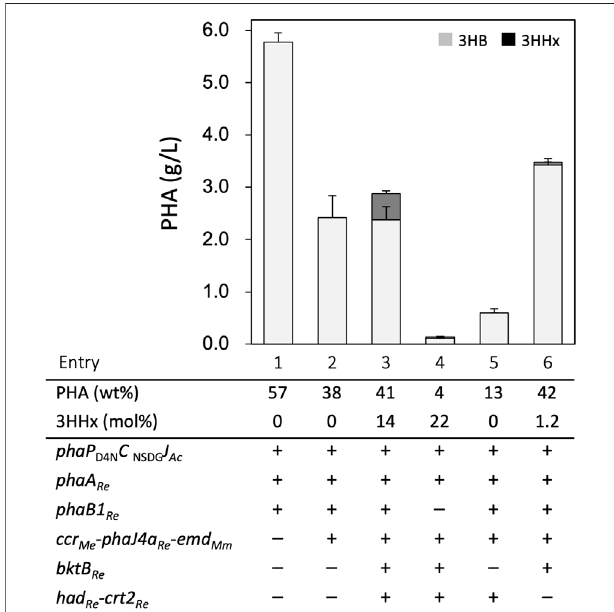
FIGURE2| P(3HB- co -3HHx)biosynthesisfromglucoseby E.coli JM109- derived recombinant strains. The amounts of 3HB and 3HHx units in PHA are showningrayand blackbars,respectively.Thecellswerecultivatedina100 ml LBmediumcontaining2%(w/v)glucoseand1 mMIPTGfor48 hat30 ° C.